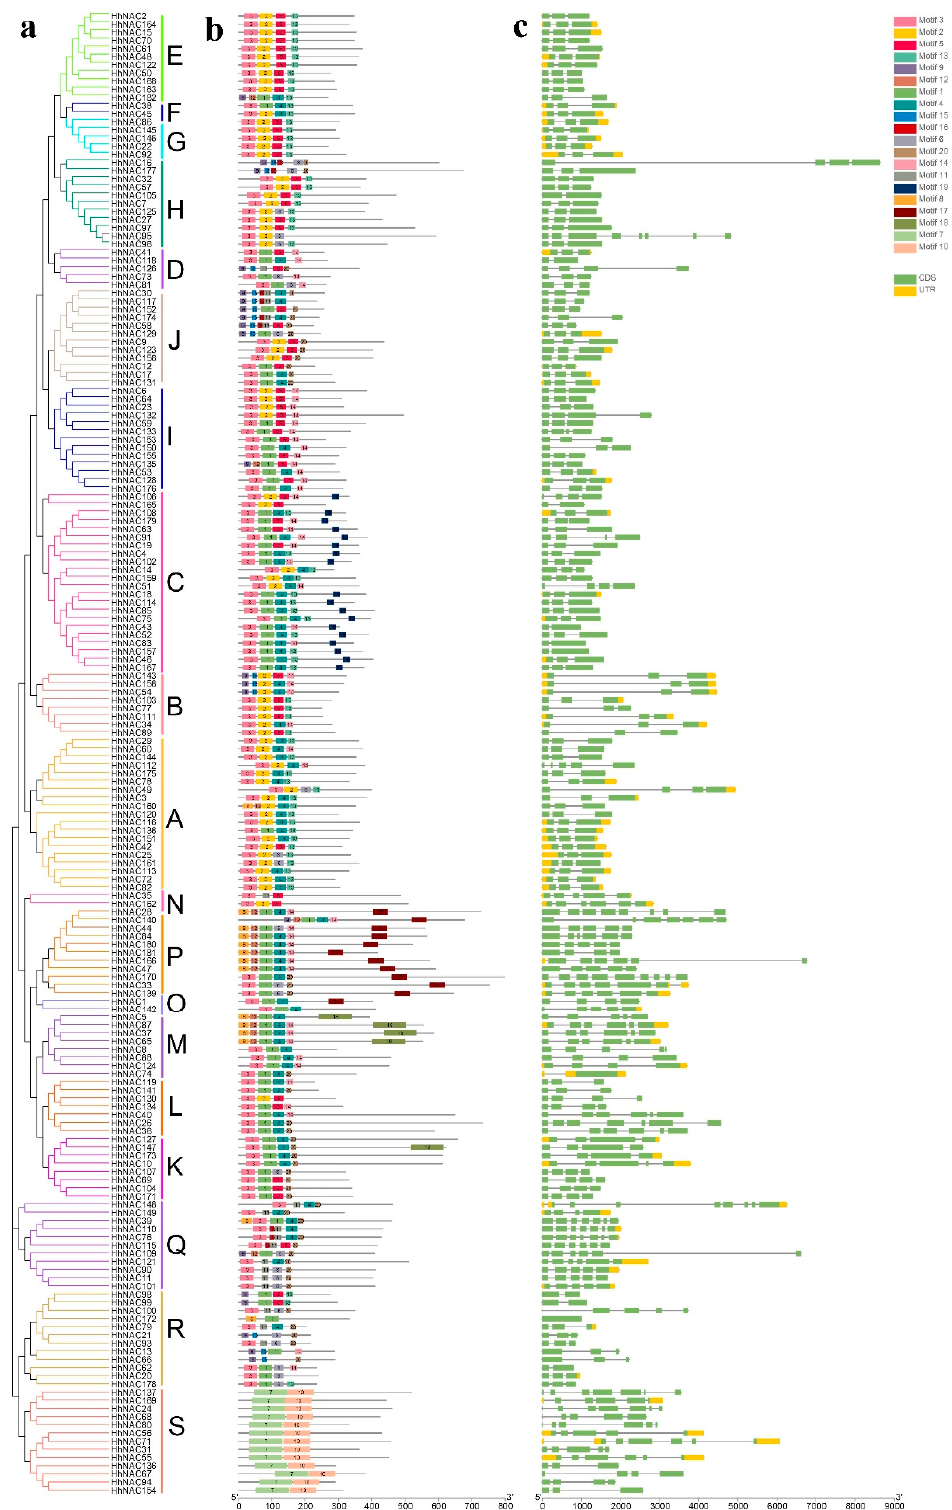
Figure 2. Map of the gene structure distribution and conserved motif patterns in H. hamabo NAC proteins. ( a ) Phylogenetic tree of HhNAC (A-S indicated 19 subfamilies). ( b ) Schematic diagram of HhNAC motif distribution. There were 20 types of motif in total, and different motifs are represented by different colors. ( c ) Schematic diagram of the HhNAC gene structure.